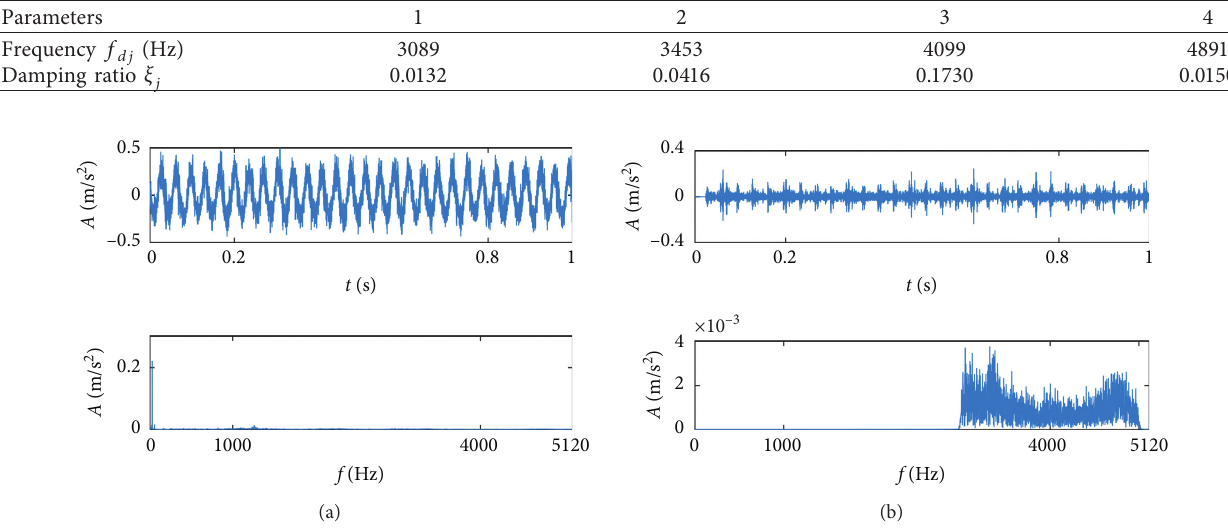
Figure 15: Experimental signal of the time domain and frequency domain under the normal state. (a) Original signal. (b) Filtered